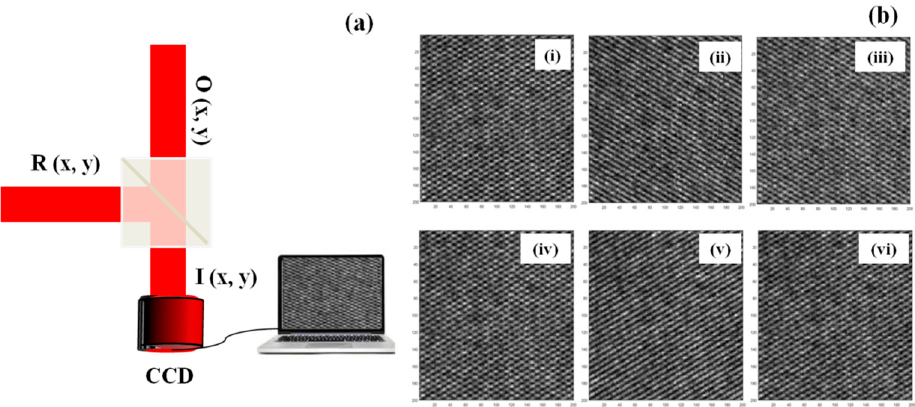
Figure 3. ( a ) Schematic of the recorded hologram (I(x,y)), ( b ) recorded interference patterns (fringes) for ( i – iii ) +45° polarized and ( iv – vi ) − 45° polarized input light at three grayscales of SLM (5, 180, and 255), respectively.